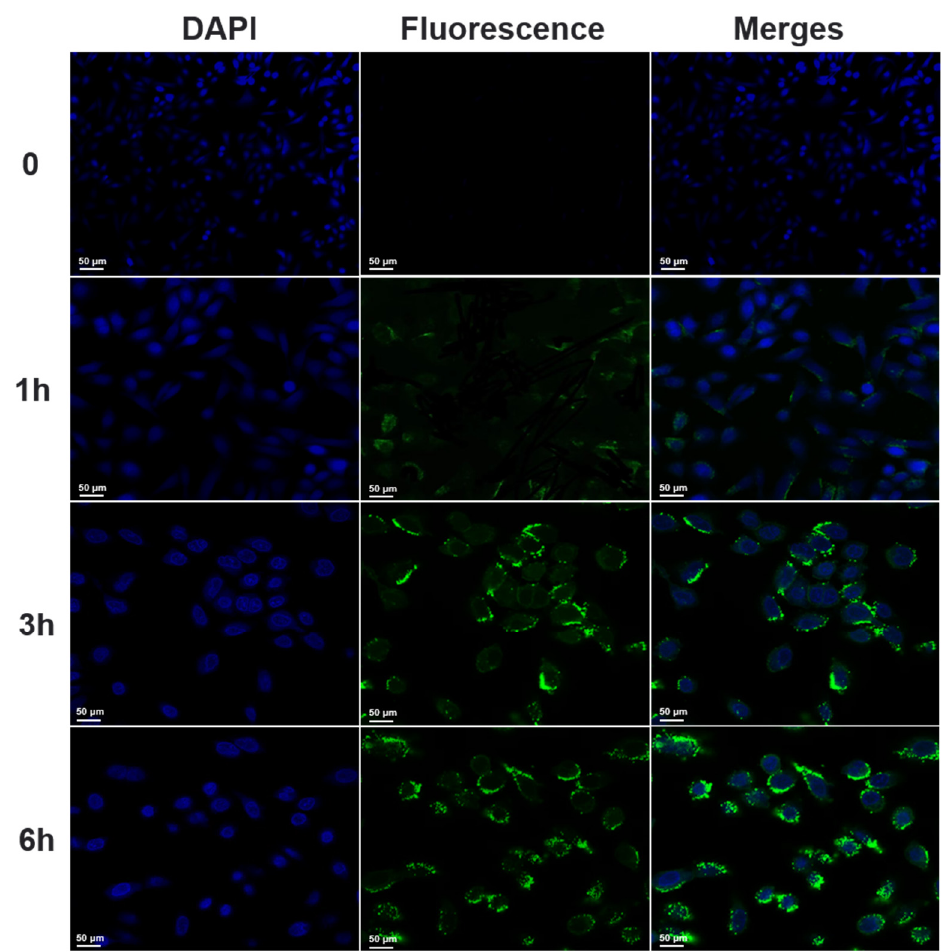
Figure 10. The cellular uptake of CK-Ngs treated with A549 cells for 0, 1 h, 3 h and 6 h were observed by CLSM (Magnification 40× and scale bar is 50 μ m).